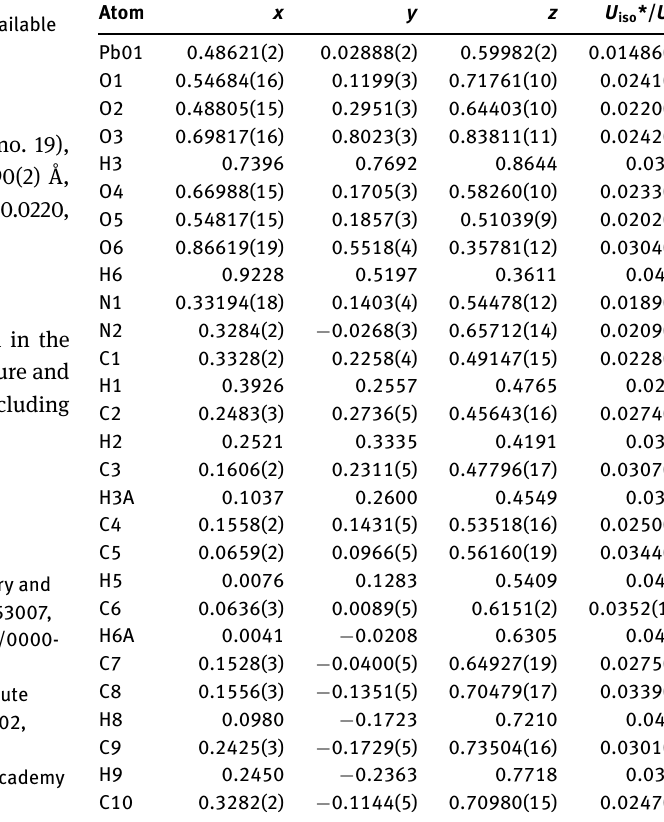
Table 2: Fractional atomic coordinates and isotropic or equivalent isotropic displacement parameters (Å 2